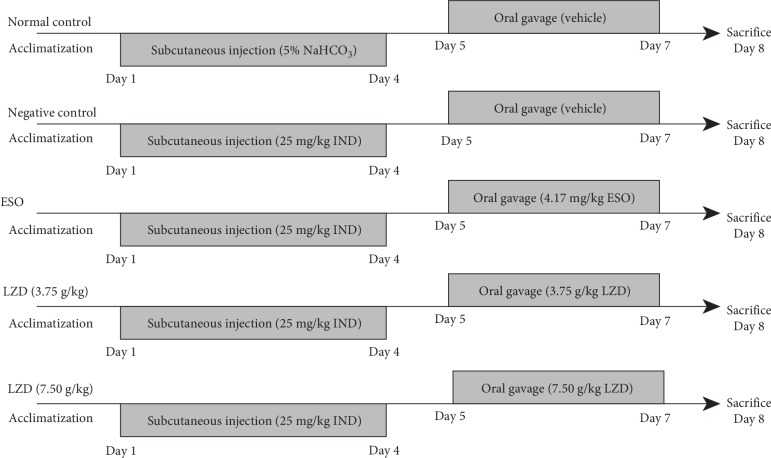
Diagram showing the experimental design and time course of treatment schedules for different groups.